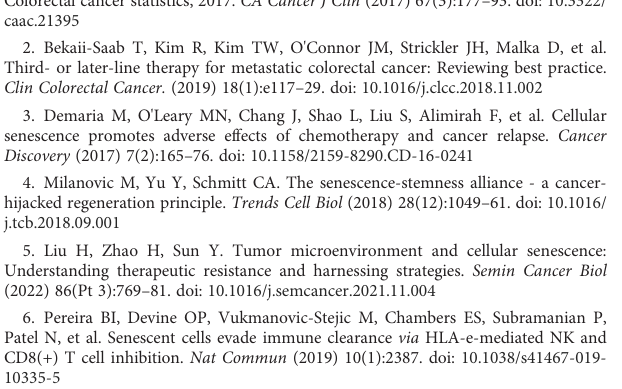
SUPPLEMENTARY FIGURE 1 The work fl owchart of our study. SUPPLEMENTARY FIGURE 2 The correlation between (A) PD-L1 or (B) TMB and angiogenetic risk scores. SUPPLEMENTARY FIGURE 3 Expression of model genes across immune cells in CRC. WNT16 were not detected in this scRNA-seq